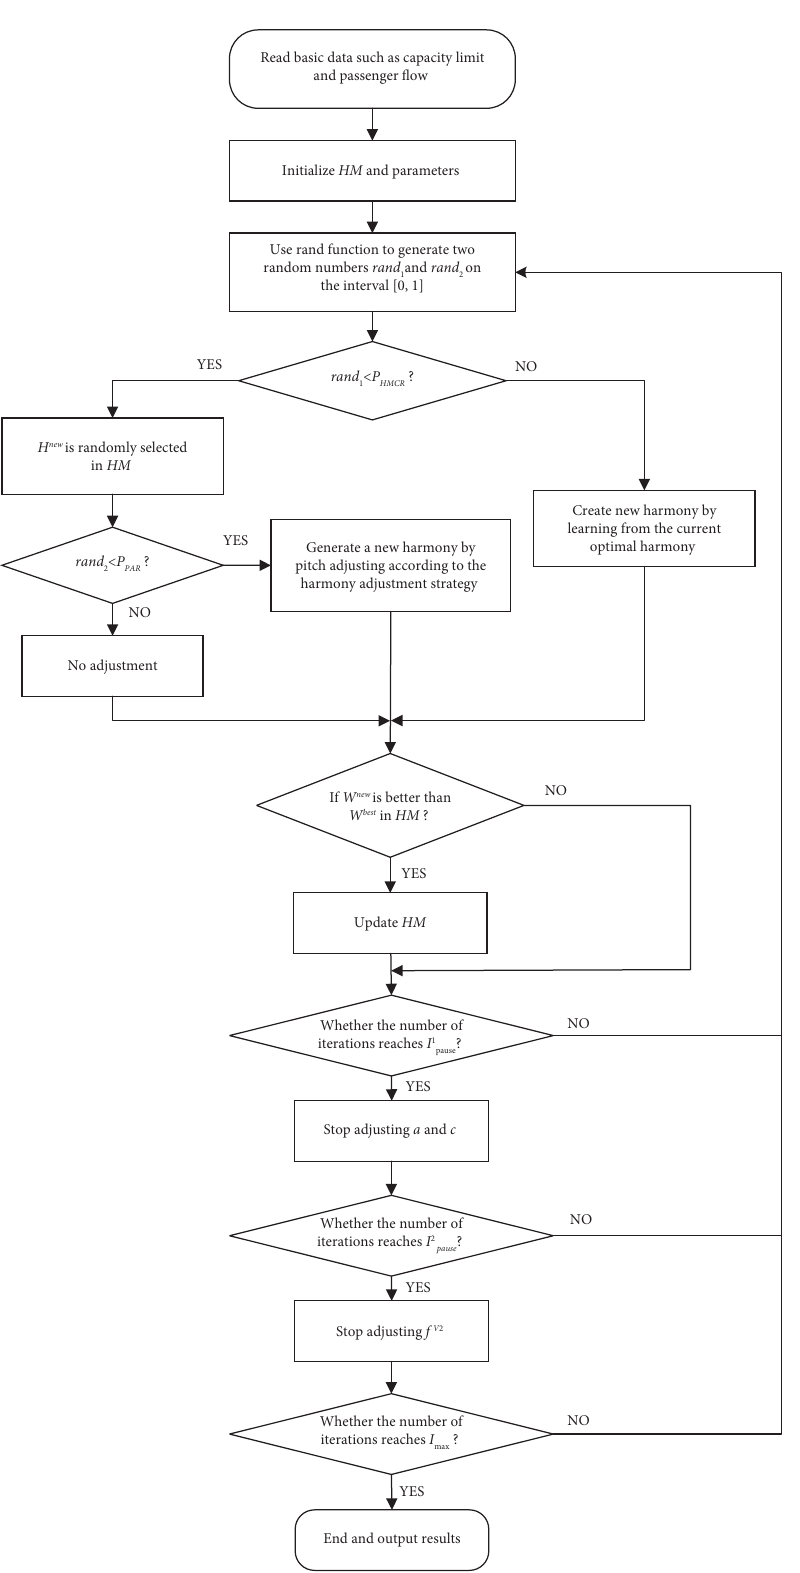
Figure 9: Flow chart of